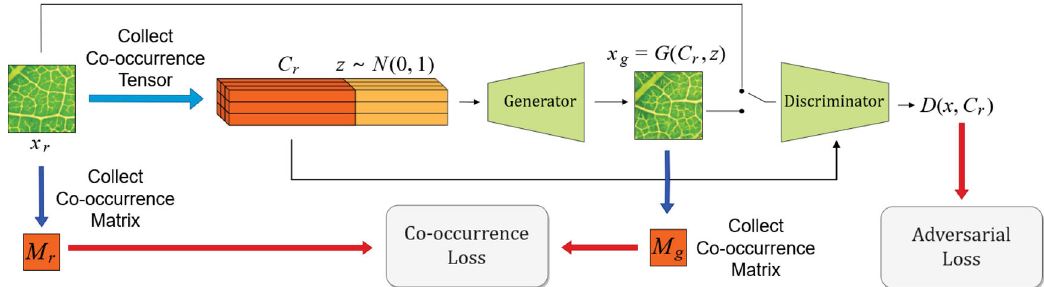
Fig. 2 Method overview. The generator receives as input a co-occurrence tensor C r , corresponding to a real texture crop x r . This tensor is concatenated to a random noise tensor z . The generator outputs a synthetic texture sample x g . The discriminator’s input alternates between real and synthetic texture samples. It also receives the co-occurrence tensor C r . In addition, the co-occurrence of the synthesized texture is required to be consistent with the input statistics to the generator. By this architecture, the generator learns to synthesize samples with desired local texture properties, as captured by the co-occurrence